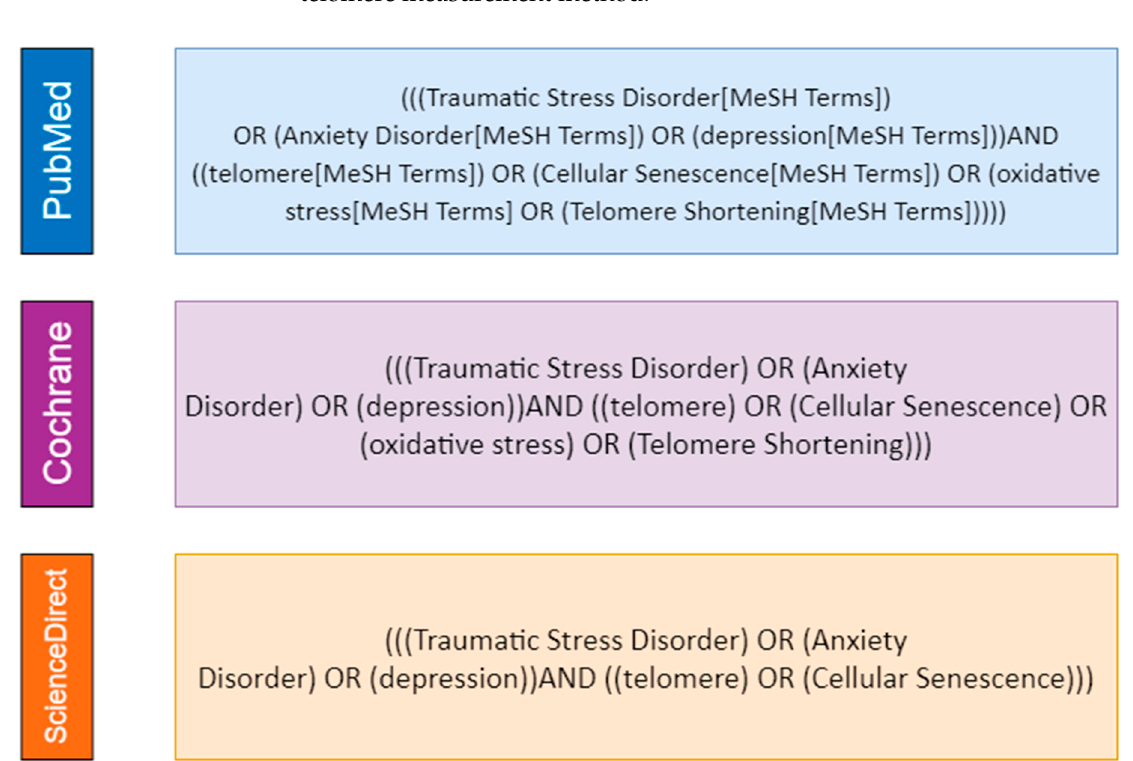
Figure 1. Descriptors employed in our systematic search on PubMed, Cochrane Library and ScienceDirect (Scopus) databases.